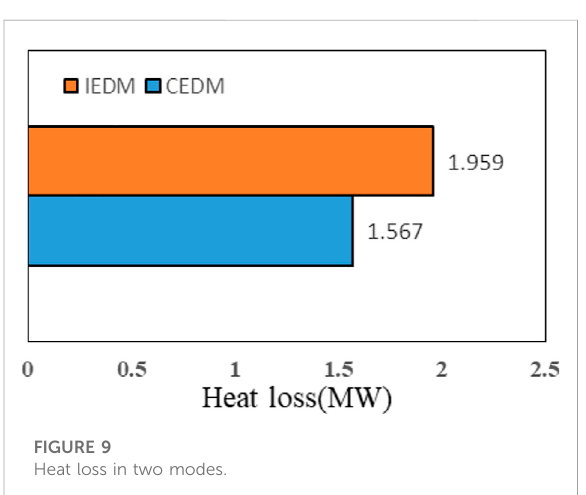
FIGURE 9 Heat loss in two modes.